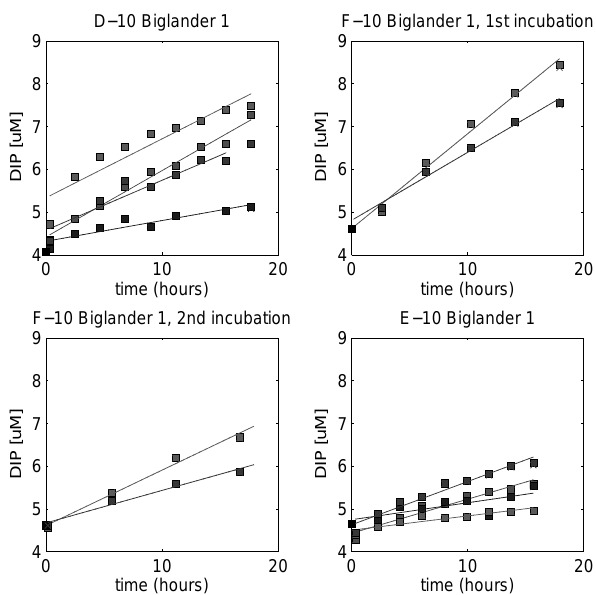
Fig. 6. Examples of evolution of the DIP concentration with time in chambers from the anoxic stations (D, E, F) on the 2010 cruise. The different shades of grey indicate different chambers. A full thin line means that the slope of the linear regression was used to calculate the flux.